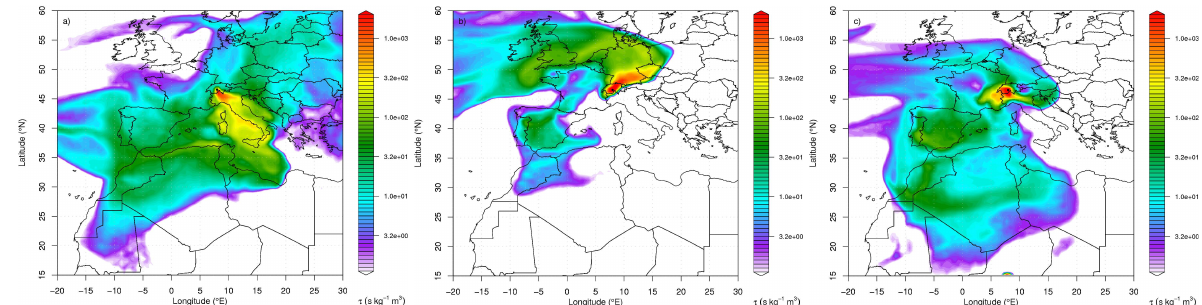
Fig. 1. Surface source sensitivities (footprints) for grouped filter samples: (left) 10–11 June 2010, North Italian influence, (centre) 29 June to 1 July 2010, Swiss and southern German influence, and (right) 09–11 July 2010 North African and Swiss influence. For plots with higher time resolution (3h), see http://lagrange.empa.ch/FLEXPART